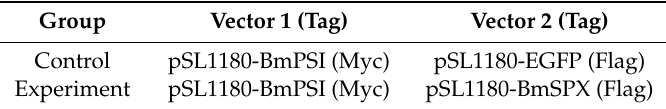
Table 4. CO-IP between BmSPX and